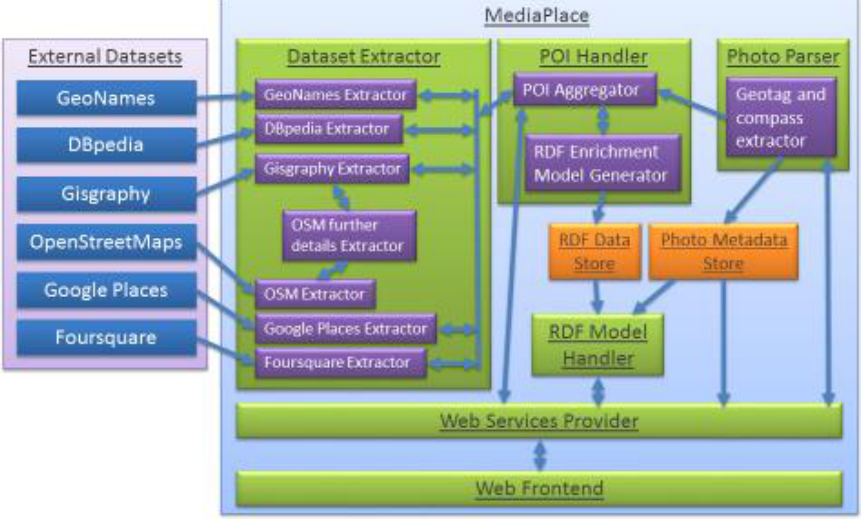
Figure 1. Diagram showing MediaPlace architecture with the external datasets on the left and our photograph enrichment system on the right. It shows each component of the system and how each component